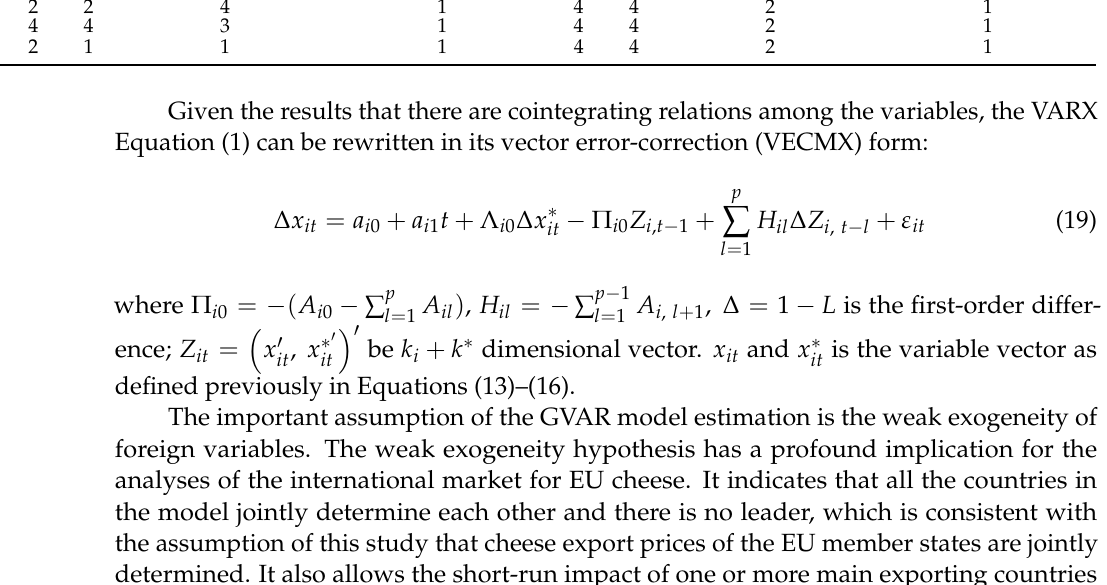
Table 3. VARX order and number of cointegrating relationships for intra-EU GVAR model and extra-EU GVAR model. Intra-EU Extra-EU Tested Adjusted Tested Adjusted p q p q Cointegrating Cointegrating Cointegrating Cointegrating Relations Relations Relations